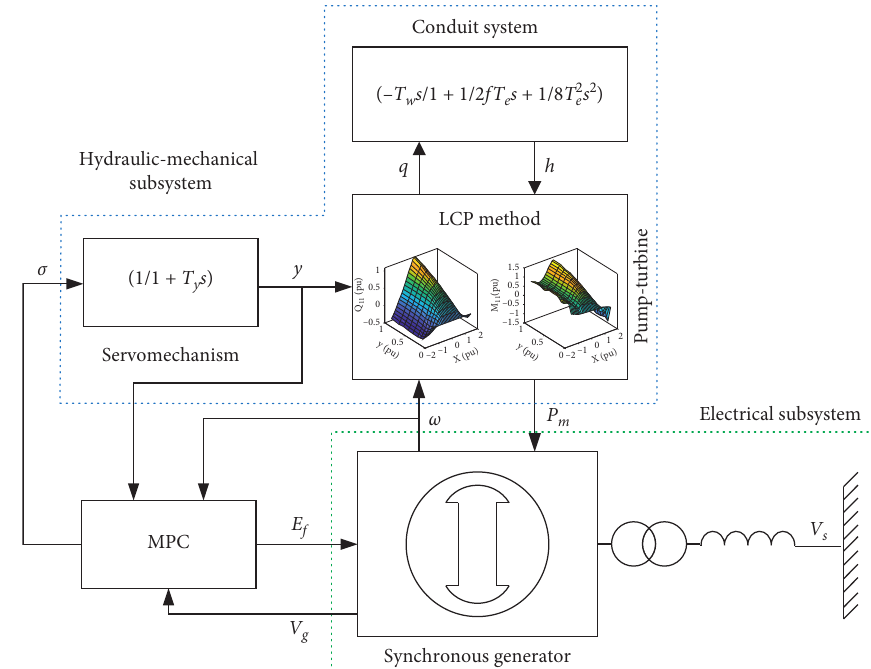
Figure 6: The block diagram of the hydraulic-mechanical-electrical coupling system of PSP.